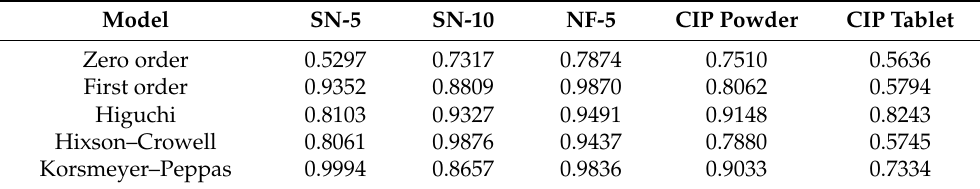
Table 5. Regression coefficient (R 2 ) values of the drug-release models and the measured ciprofloxacin (CIP) release from the